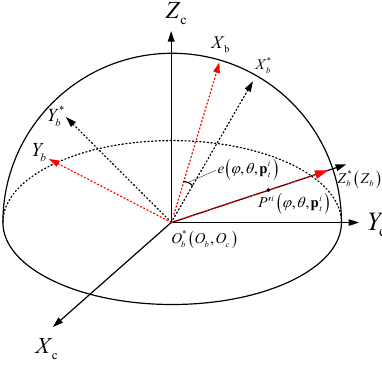
Figure 9. The definition of feature point direction angle error between calculated direction and ground truth